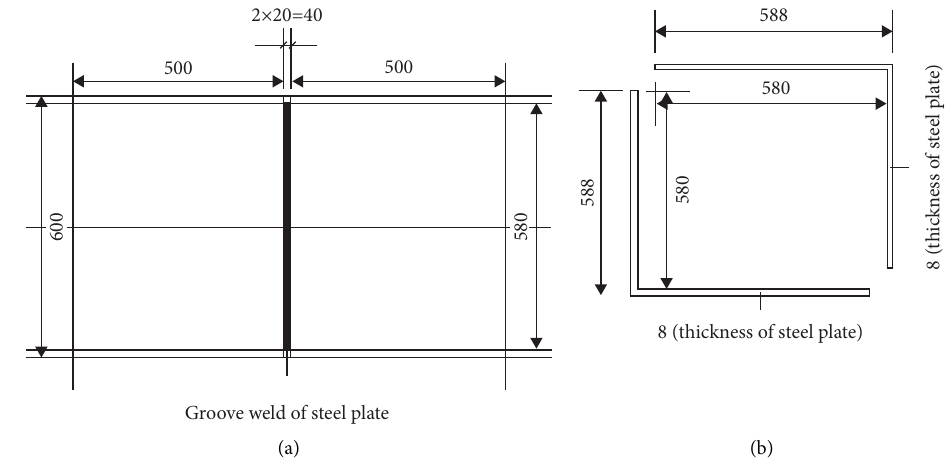
Figure 1: Schematic diagram of pile connection technology (unit: mm). (a) Connection location of pile. (b) Hoop steel plate.